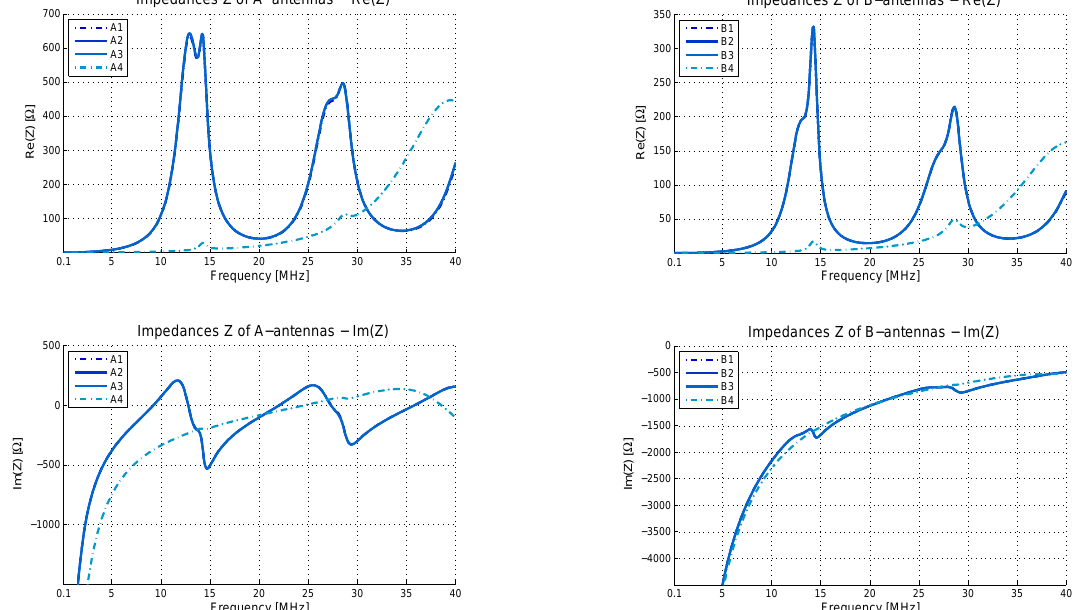
Figure 7. Self-impedances of the boom antennas A 1– A 4 (left) and the short cylindrical sensors B 1– B 4 (right). The shown quantities are the diagonal elements of the impedance matrix Z as a function of frequency. Upper panels contain the real parts, lower panels the imaginary parts. The curves for the boom antennas A 1– A 3 and sensor B 1– B 3 are nearly identical, which is due to the high symmetry of their deployment on the satellite.